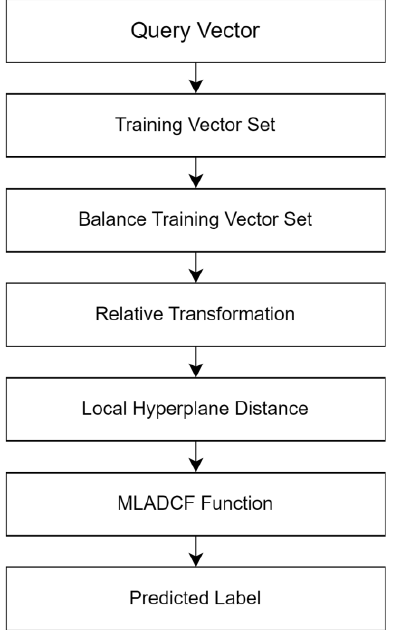
Figure 3. HRCKNN Overview for Stage 2.